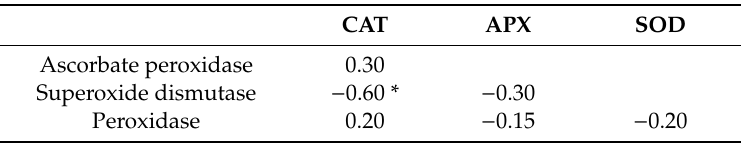
Table 8. Linear relationships between antioxidant enzymes in the popular varieties of sugarcane, SP80-1842 and SP80-3280, with spray application of chemical ripening agents. CAT APX SOD Ascorbate peroxidase 0.30 Superoxide dismutase − 0.60 * − 0.30 Peroxidase 0.20 − 0.15 −